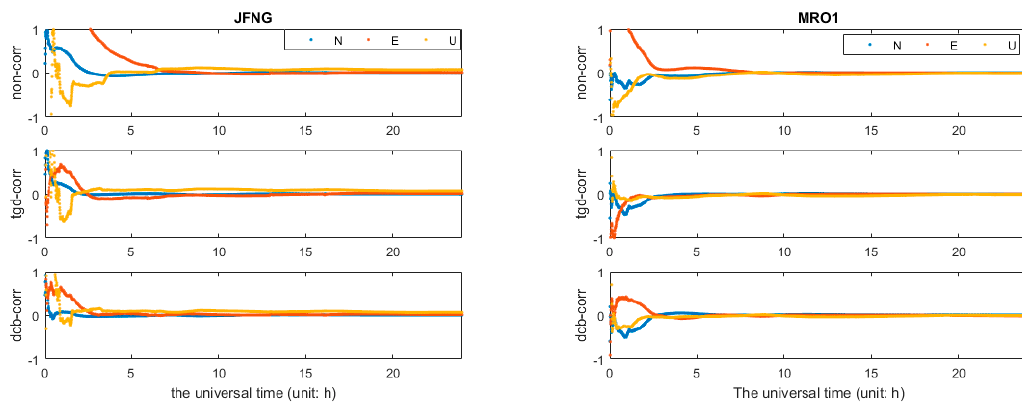
Figure 7. Positioning error (N, E, and U) of b1b2 quad-constellation PPP. For each plot, the horizontal axis represents the universal time (unit: h), and the vertical axis represents the corresponding positioning error (unit: m).